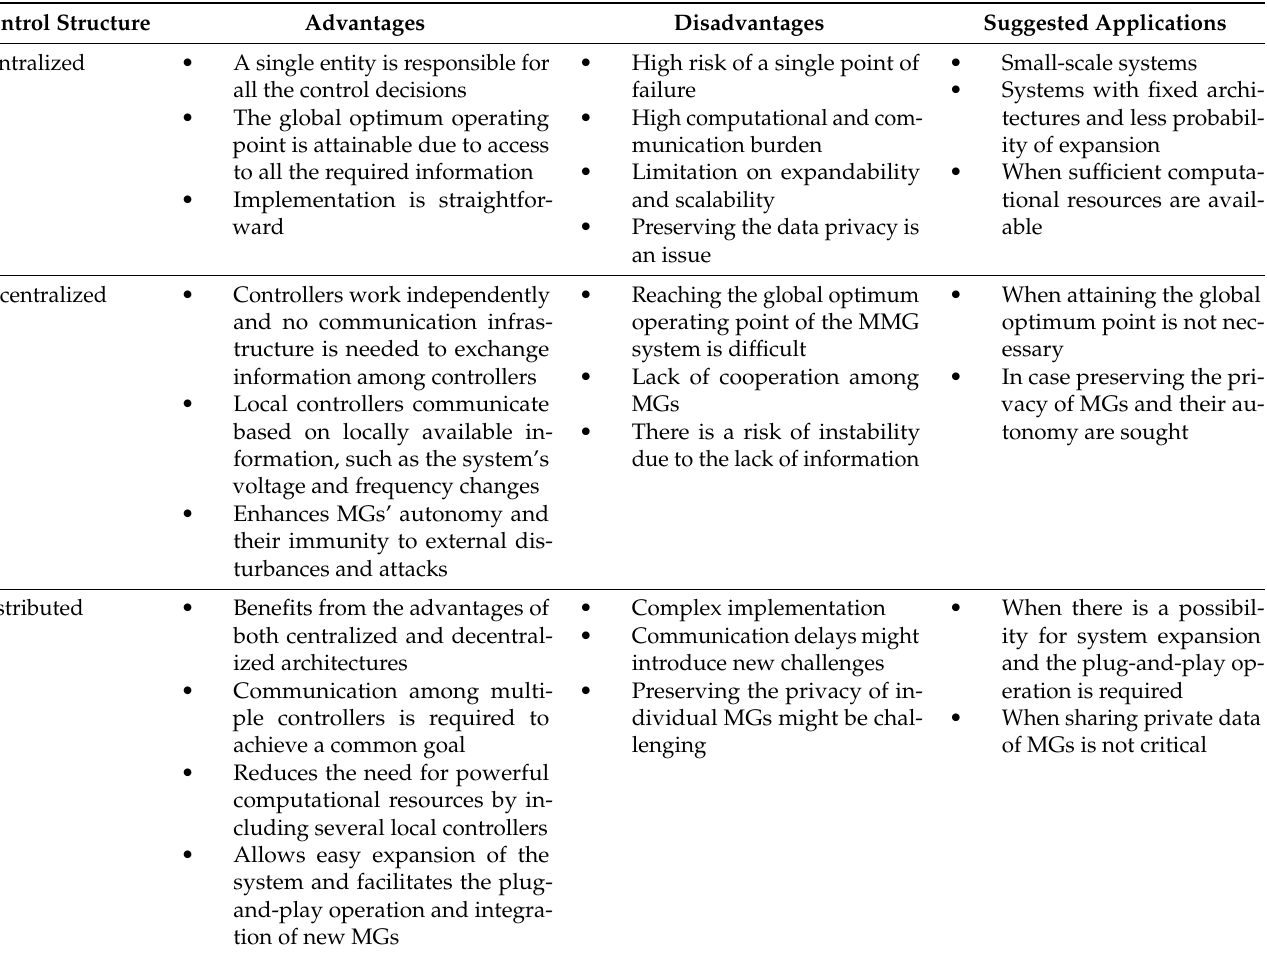
Table A1. Summary of different control